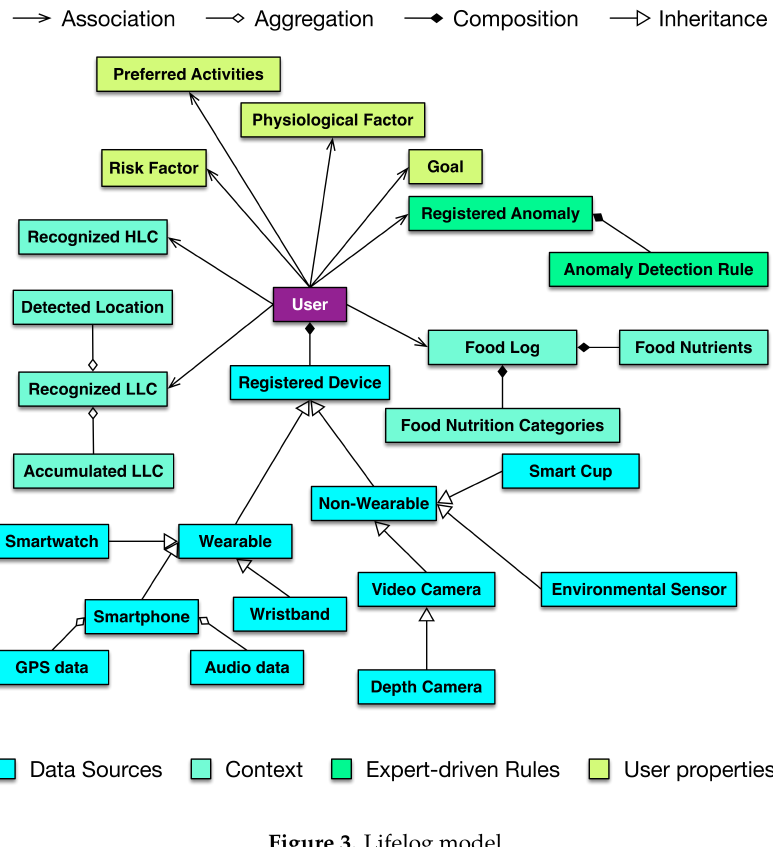
Figure 3. Lifelog